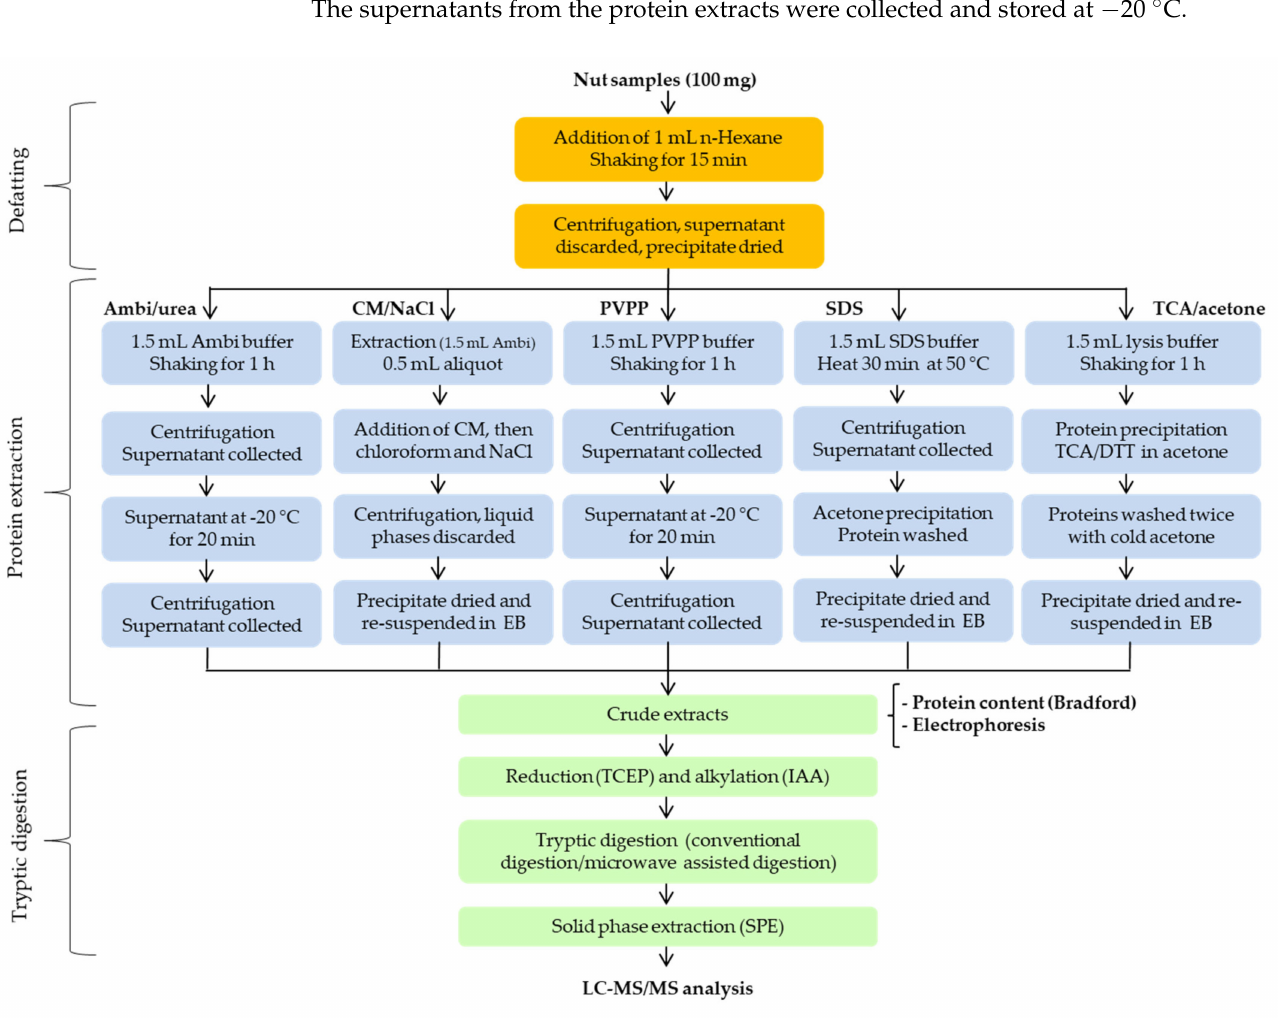
Figure 6. Schematic flowchart of the four protein extraction protocols used. CM is the mixture of chloroform/methanol (ratio 2:1); EB the extraction buffer consisting of 100 mM ammonium bicarbonate and 4 M urea; DTT the reducing agent dithiothreitol; TCEP the reducing agent tris(2-carboxyethyl)phosphine and IAA the alkylation agent